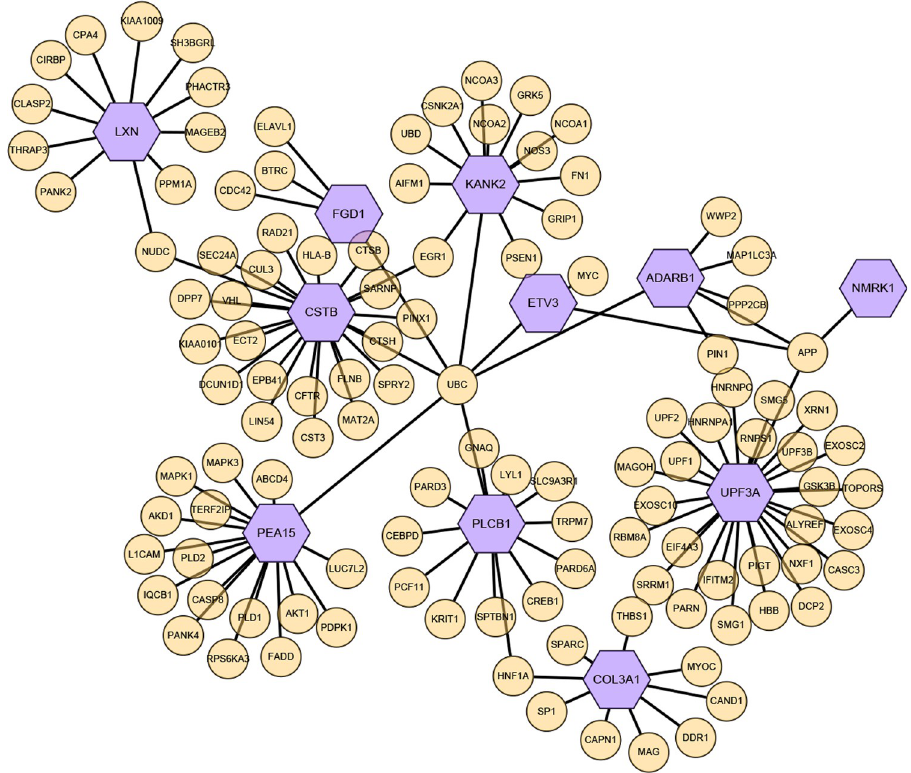
Fig 4. PPI network for common DEGs shared by two diseases. Nodes in purple color indicated common DEGs.